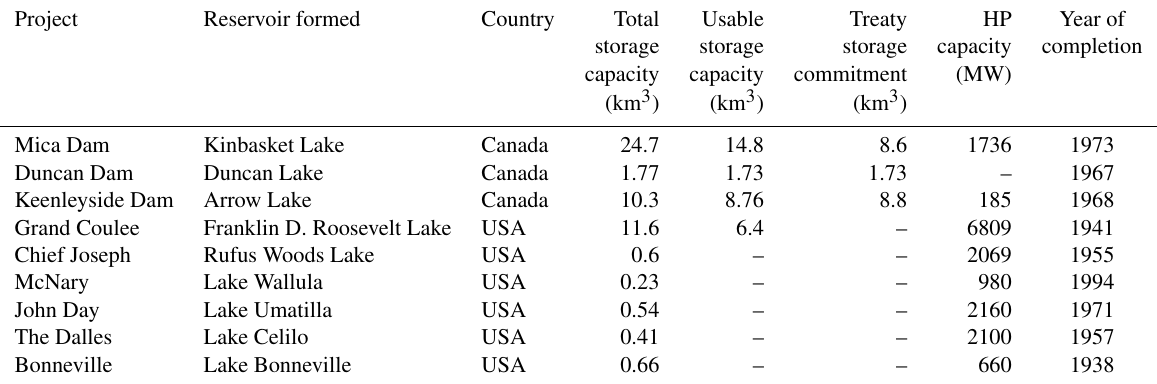
Table 1. List of dams represented by the model. Projects that do not present usable storage capacity are run-of-the-river dams. Treaty storage commitment refers to the room available to accommodate glacier waters under the